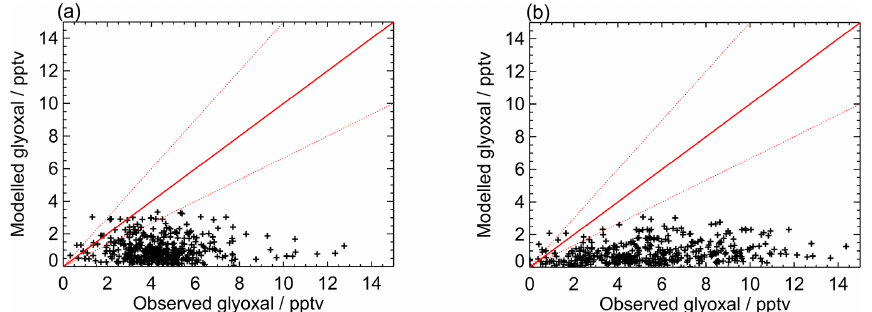
Figure 8. Modelled vs observed glyoxal for (a) the first measurement period and (b) the second measurement period for the base model run. Red lines show the 1 : 1 line, with ± 50% given by the dashed red